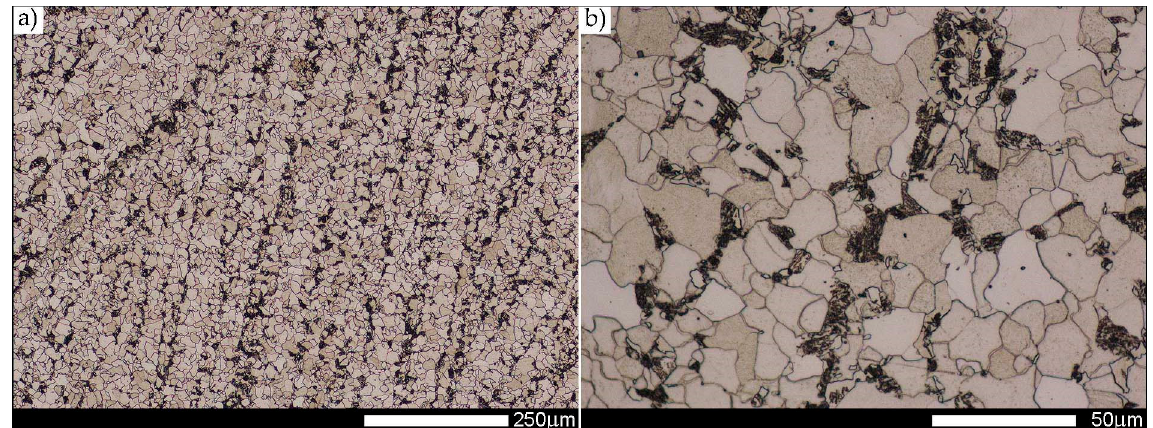
Figure 14. Microstructure of welded joint of Hardox 450 steel in the normalised state—WM1 zone shown in Figure 2b. ( a ) 100×; ( b ) 500×. The structure mainly consists of near-equilibrium grains of ferrite with pearlite exhibiting banded structure according to the direction of weld metal crystallisation. Some tertiary cementite precipitates are also observed at the ferrite grain boundaries. Light microscopy, etched with 3% HNO 3 .